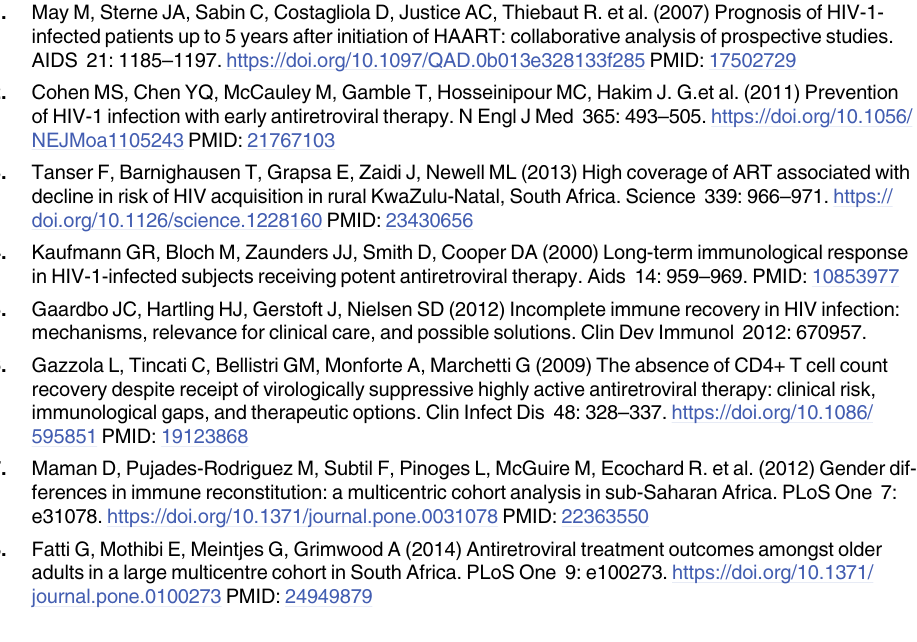
S6 Table. Predicted CD4 counts at 12 months post ART initiation by baseline CD4 counts and calendar year of ART initiation (N = 1 070